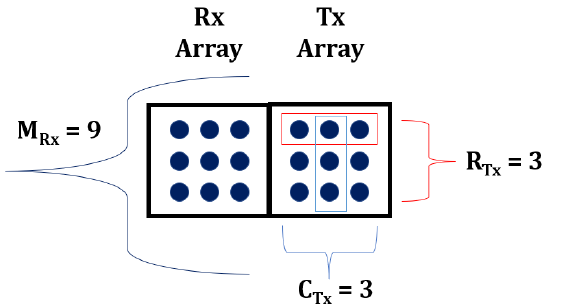
Figure 2. Example base station with M Rx = M Tx = 9 and R Tx = C Tx = R Rx = C Rx =